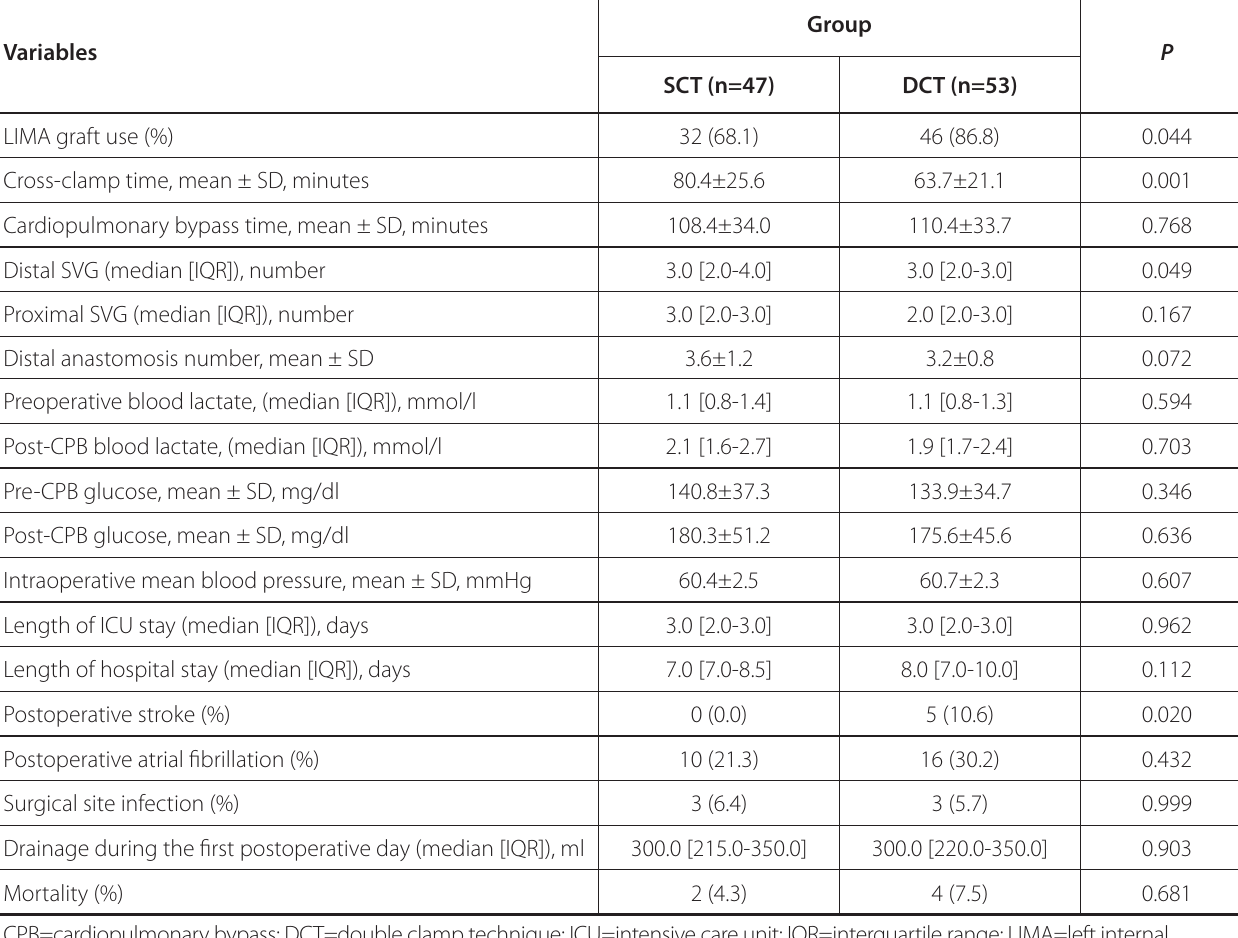
Table 2 . Preoperative and postoperative blood lactate levels, operative characteristics, postoperative complications and mortality rates in SCT and DCT